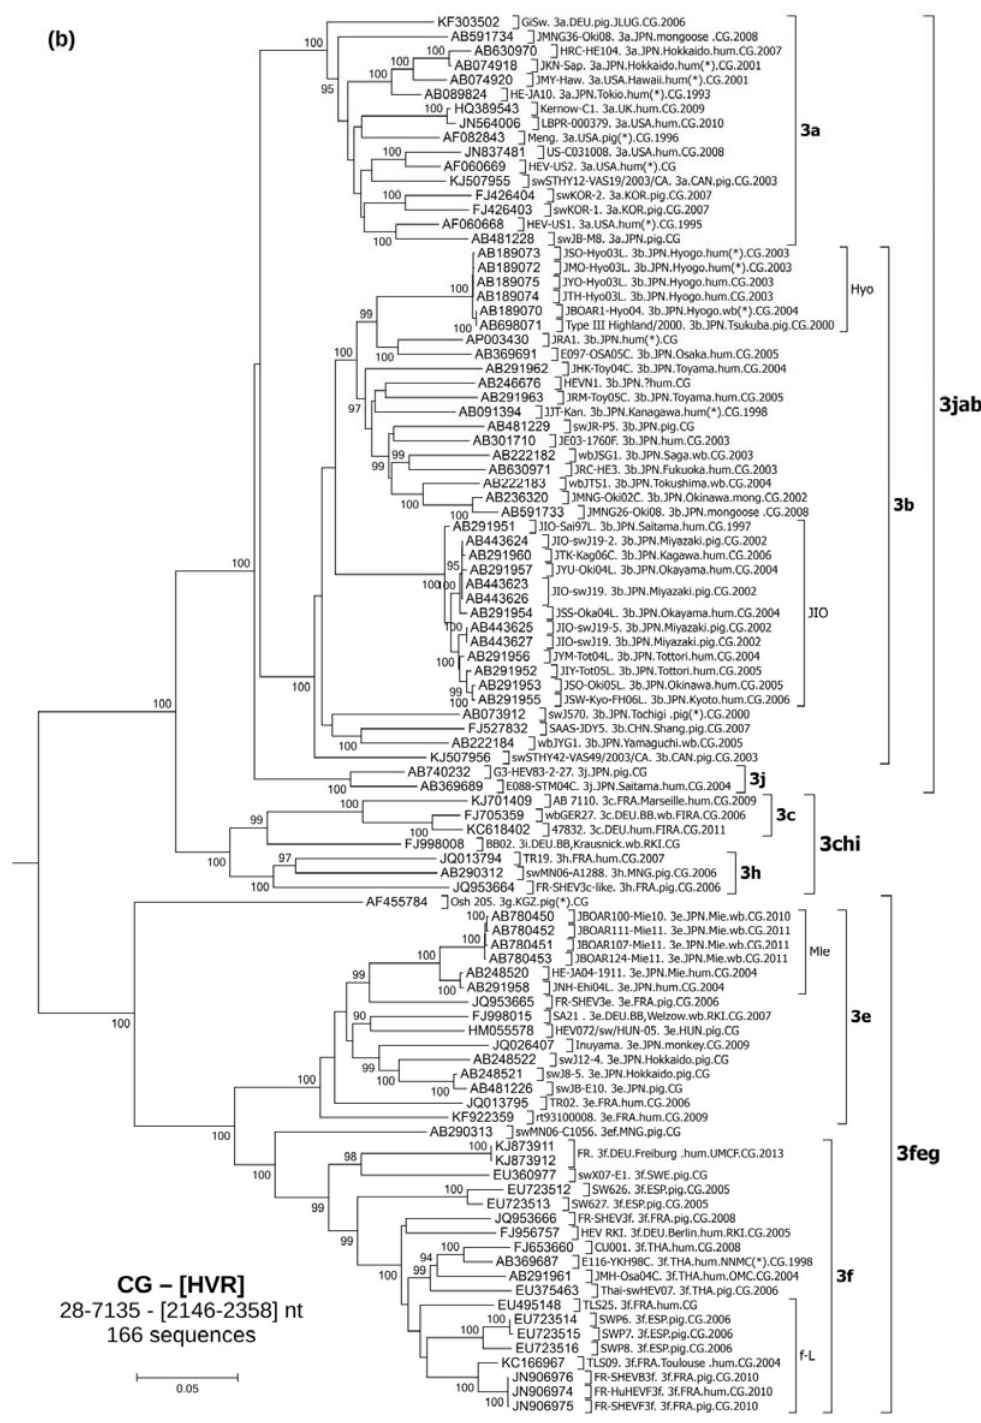
Figure 1. Molecular Phylogenetic analysis of 166 complete HEV genomes by Maximum Likelihood method based on the Kimura 2-parameter model. The percentage of trees (from 500 bootstrap replicates) in which the associated taxa clustered together is shown next to the branches when over 70%. Initial tree(s) for the heuristic search were obtained by applying the Neighbor-Joining method to a matrix of pairwise distances estimated using the Maximum Composite Likelihood (MCL) approach. A discrete Gamma distribution was used to model evolutionary rate differences among sites (five categories (+G, parameter = 0.5255)). The tree is drawn to scale, with branch lengths measured in the number